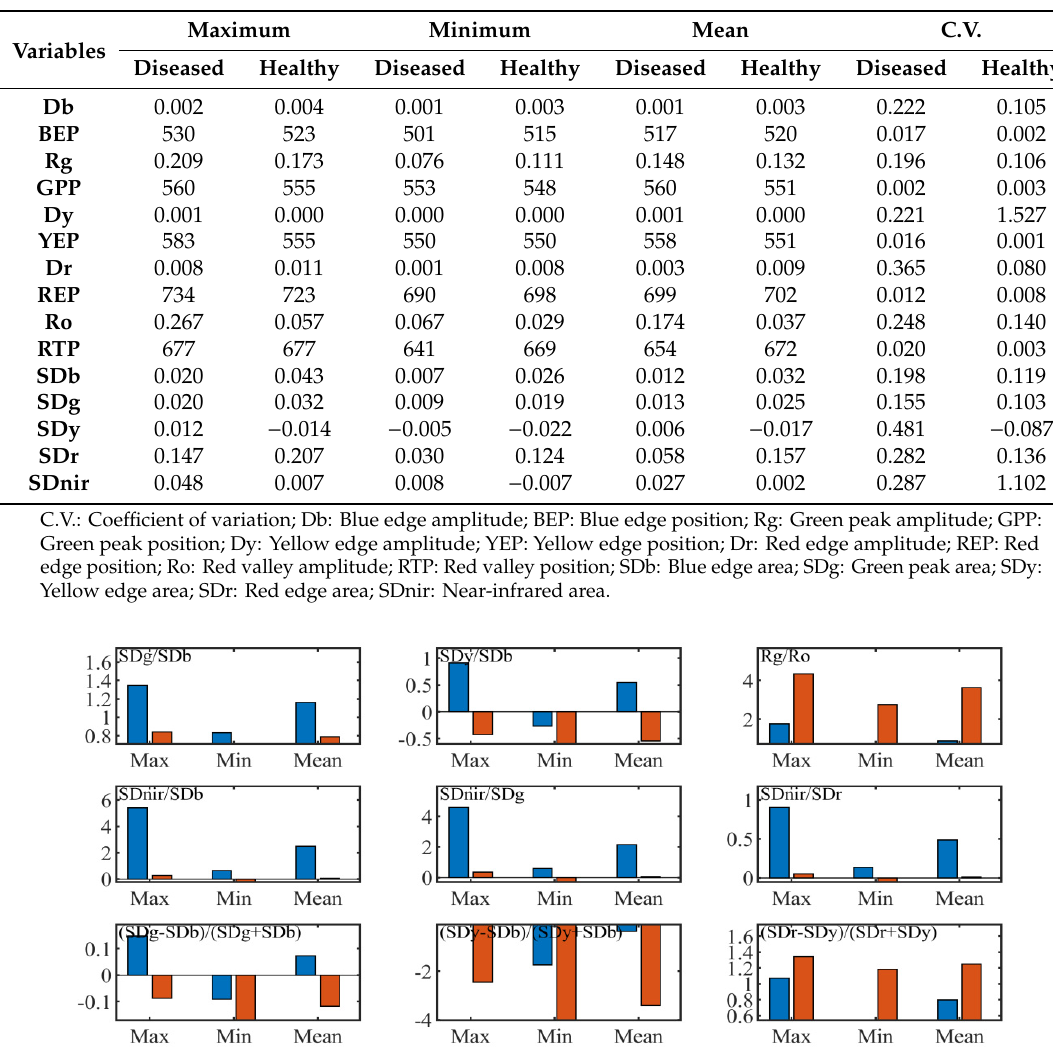
Table 1. Descriptive statistics of spectral position, amplitude and area.